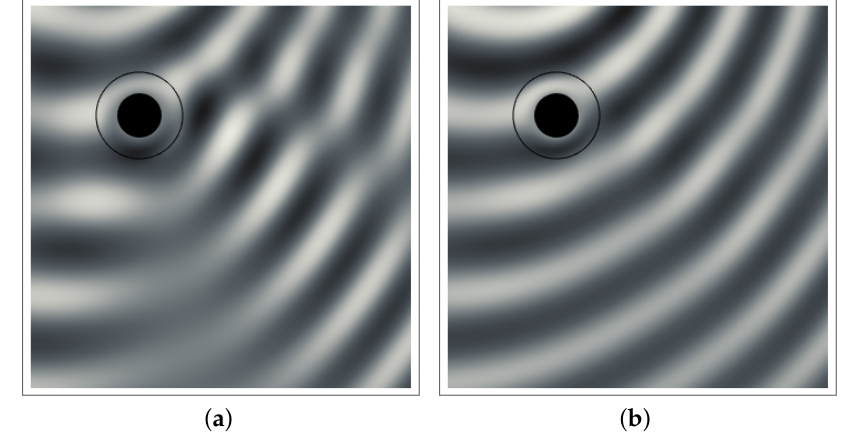
Figure 10. Acoustic cloaking in the presence of flow. The classic transformation acoustic theory defines a metamaterial that fails during abate scattering for the Mach number M (cid:54) = 0 ( a ). A correction of metamaterial parameters, as derived in [92], can recover the cloaking effect, even for M = 0.3 (flow incoming from the right) ( b